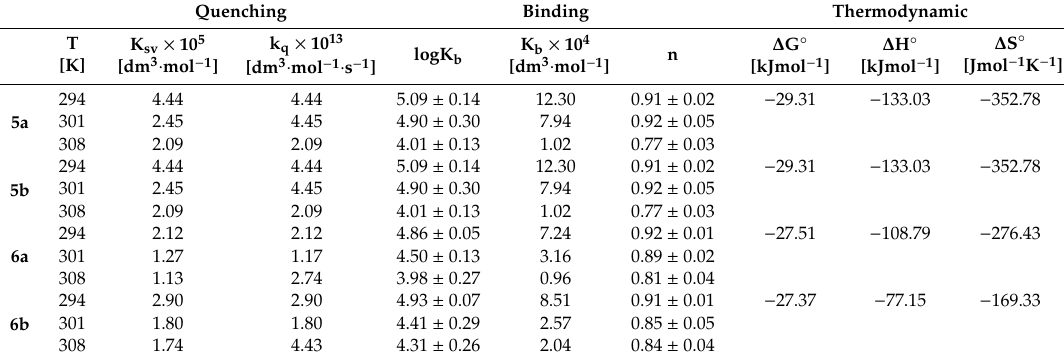
Table 5. The Stern–Volmer constant K SV and the quenching rate constant k q , binding constants K b and number of binding sites n, thermodynamic parameters for the interaction of BSA with studied compounds at different temperatures. Binding